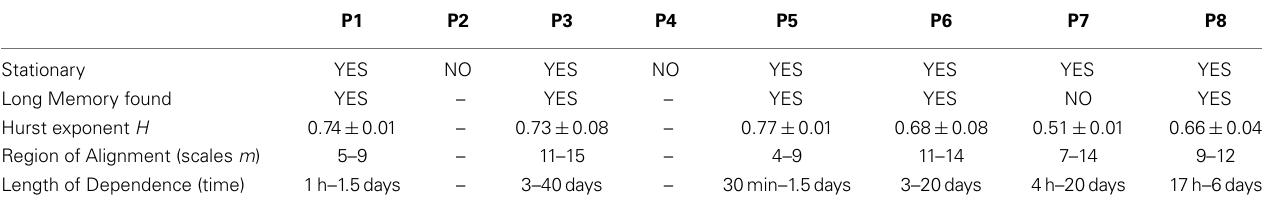
Table 2 | Summary of results